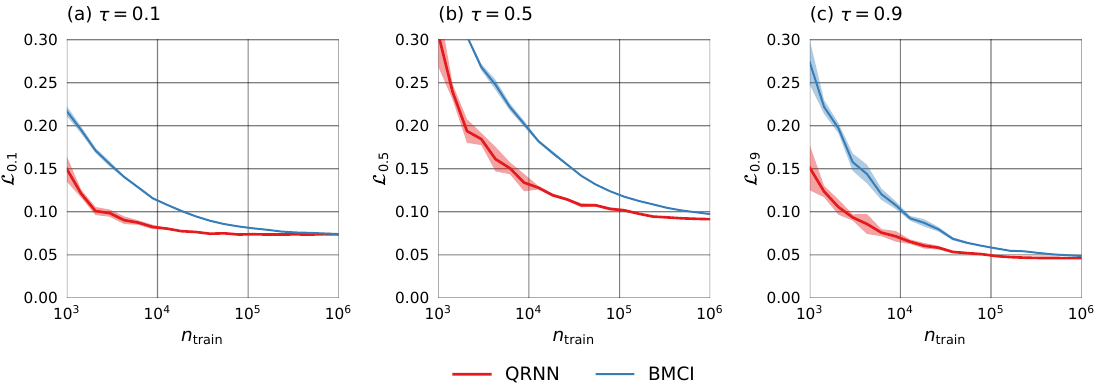
Figure 7. Mean quantile loss for different training set sizes n train and τ = 0 . 1, 0.5 and